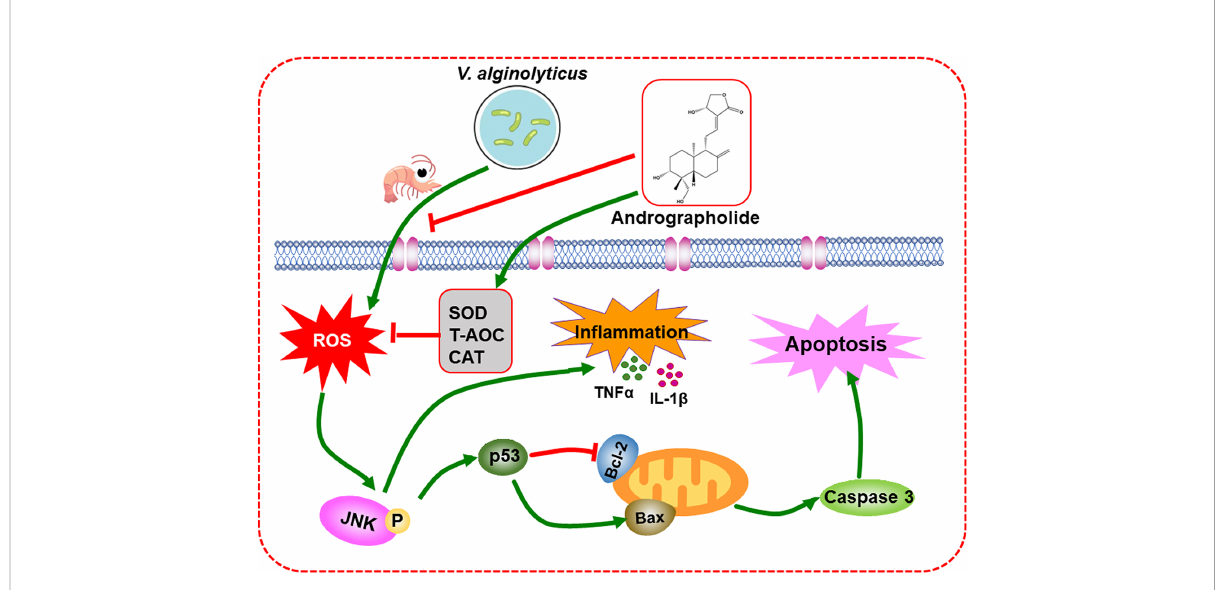
FIGURE 9 Schematic representation of the inhibitory mechanism of Andr on V. alginolyticus -induced in fl ammation and